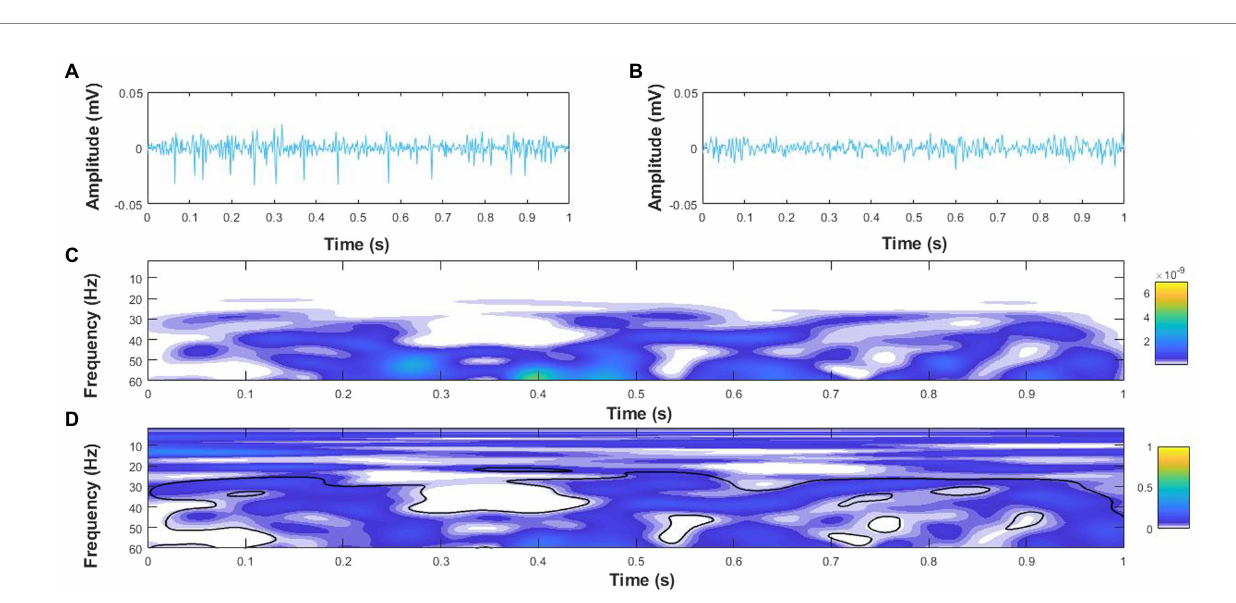
FIGURE 2 Example coherence analysis for a 1 s epoch of surface electromyography (EMG) signals for the medial gastrocnemius (MG), (A) and soleus (B) of an older adult with PD during single leg stance. (C) Wavelet cross-spectrum of the MG and soleus EMG signals, and (D) Wavelet-magnitude squared coherence between MG and soleus EMG in the time-frequency domains with the black outline denoting regions with significant coherence. The yellow and blue scales on the right-hand side represent the power of the cross-spectrum (C) and magnitude-squared coherence (D) ,